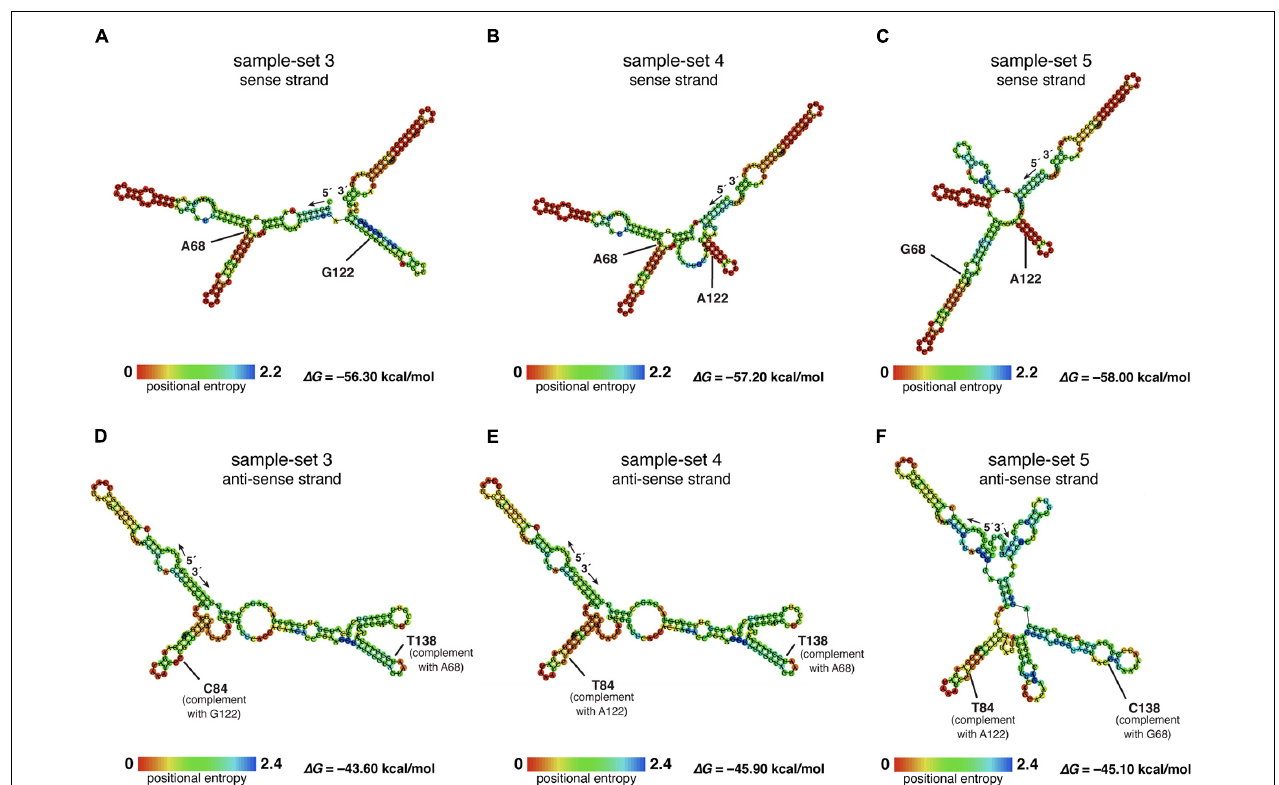
FIGURE 8 | Putative RNA secondary structure of the PCR–single-strand conformation polymorphism (SSCP) amplicons of sample-sets 3–5. The putative RNA folding structures based on the minimum free energy ( (cid:52) G ) of the PCR-SSCP amplicons of sample-set 3 (A,D) , sample-set 4 (B,E) , and sample-set 5 (C,F) were generated by ViennaRNA Package 2.0 (Lorenz et al., 2011). The top panels are the putative structures of the sense strand of each sample-set, whereas the bottom panels are the putative structures of the anti-sense strand of each sample-set. Ribonucleotide residue at substitution sites 68 and 122 of the three sense strands are labeled with ribonucleotide abbreviation adjacent to the position, as A68, G68, G122, and A122 (A–C) . Positions 138 and 84 of the anti-sense strand, which corresponded to positions 69 and 122 of the sense strand, respectively, are labeled as C84, T84, T138, and C138. The free energy ( (cid:52) G ) values of the most stable RNA secondary structure of each sample-set are presented at the lower-right corner. The rainbow bars at the lower-left corner of each structure demonstrate positional entropy of ribonucleotide